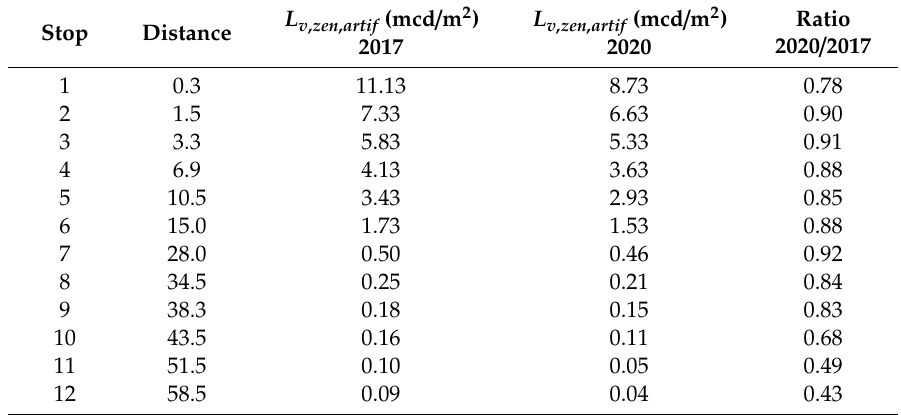
Table 2. Artificial component of zenith luminance ( L v , zen , artif ) for the two measurement transects and between the two datasets obtained by dividing the artificial component of the zenith brightness values from 2020 by that of